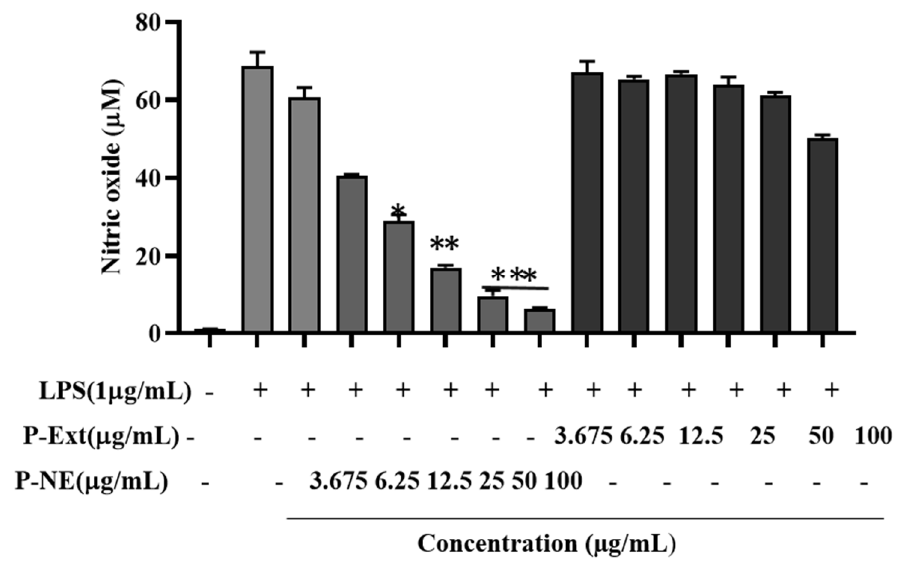
Figure 5. The effects of Panos nanoemulsion on NO production were assessed by 1 µg/mL LPS induced RAW 264.7 cells. Data presented as ±SEM, * p < 0.05 ** p < 0.01 vs. normal control. All treatment was performed three times.